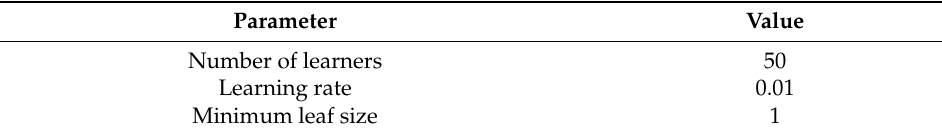
Table 3. LSBoost parameters.